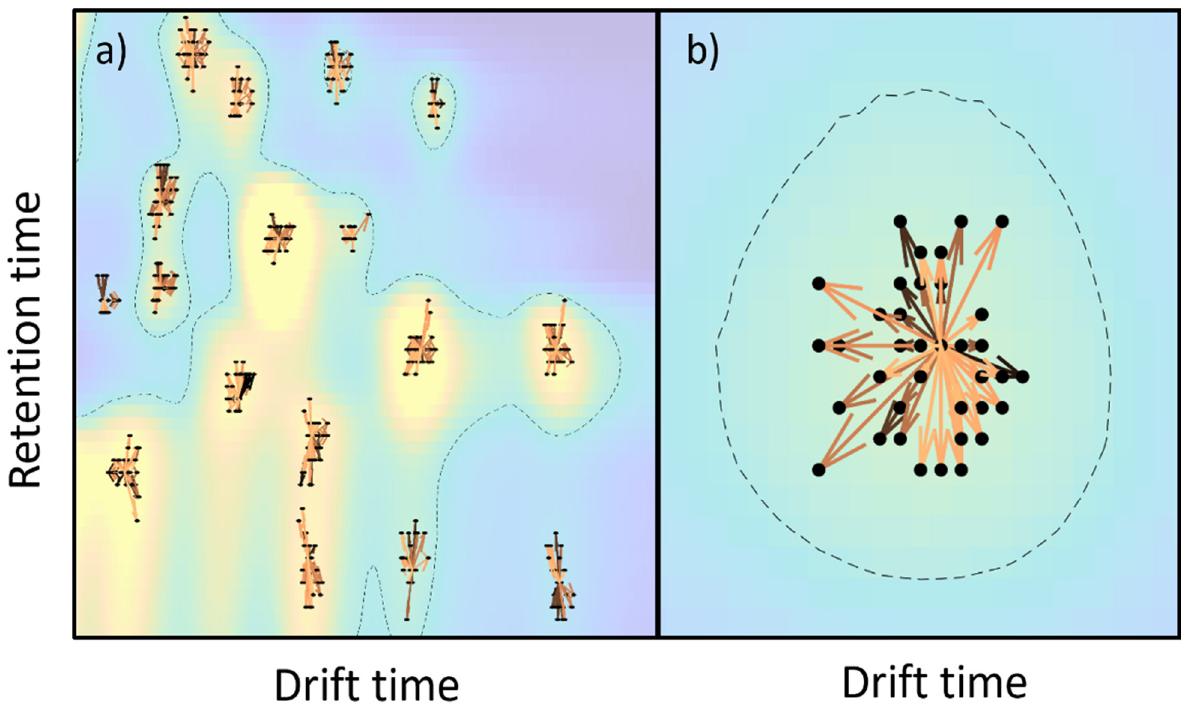
Figure 3. ( a ) Peak alignment across all samples (the color-coded image is the mean response across the dataset), ( b ) magnified view of peak alignment. In both subplots, arrows indicate the centroid shift, colored by time. The dashed line indicates those regions over a specific noise level.